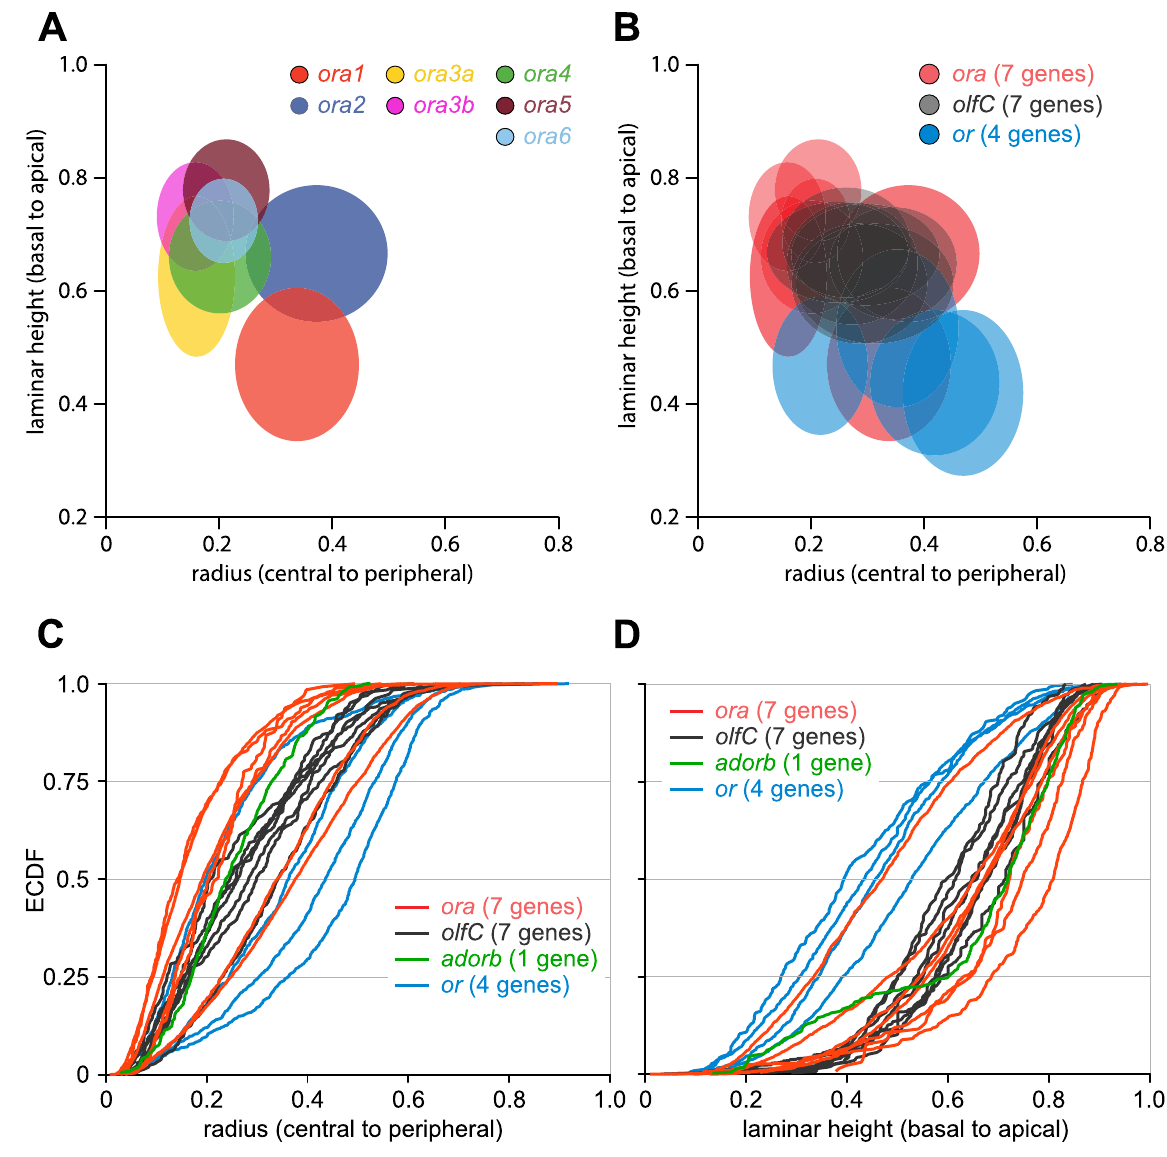
Figure 6. Multidimensional analysis of spatial expression patterns shows significantly different expression zones for all ora genes and clear segregation from two other olfactory receptor families. ( A ) Comparison of spatial distribution parameters between ora genes. Schematic representation of spatial distributions for all ora genes by ellipses ranging from the 1st to the 3rd quartile value for radial (x axis) and laminar height (y axis) parameter. Color code for ora genes as before. ( B ) Comparison of distributions for ora versus olfC and odorant receptor ( or ) genes using the same coordinates and representation as in ( A ). Note that the color code is changed compared to panel ( A ). The raw data for olfC genes are taken from 11 , raw data for the radial parameter of or genes are from 7 . For names and quartile values of or and olfC genes see SI Table 1. ( C , D ) Distributions of ora -expressing OSNs intercalate between those of other olfactory receptor families. Distributions are shown as ECDFs. Red lines, ora genes; black, olfC genes; blue, or genes. Panel ( C ) shows the distribution for the radial coordinate, panel ( D ) depicts the laminar height